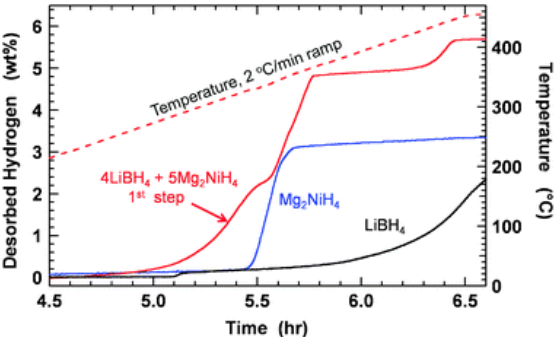
Figure 12. Dehydrogenation of 4LiBH 4 + 5Mg 2 NiH 4 , Mg 2 NiH 4 , and LiBH 4 conducted using a 2 ◦ C min − 1 temperature ramp under 4 bar of H 2 . Reprinted from